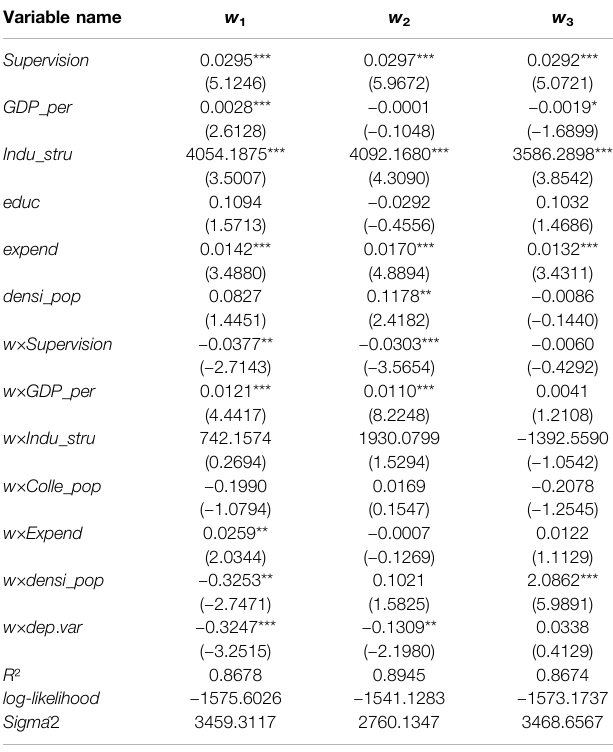
TABLE 1 | Regression estimation results of spatial Durbin